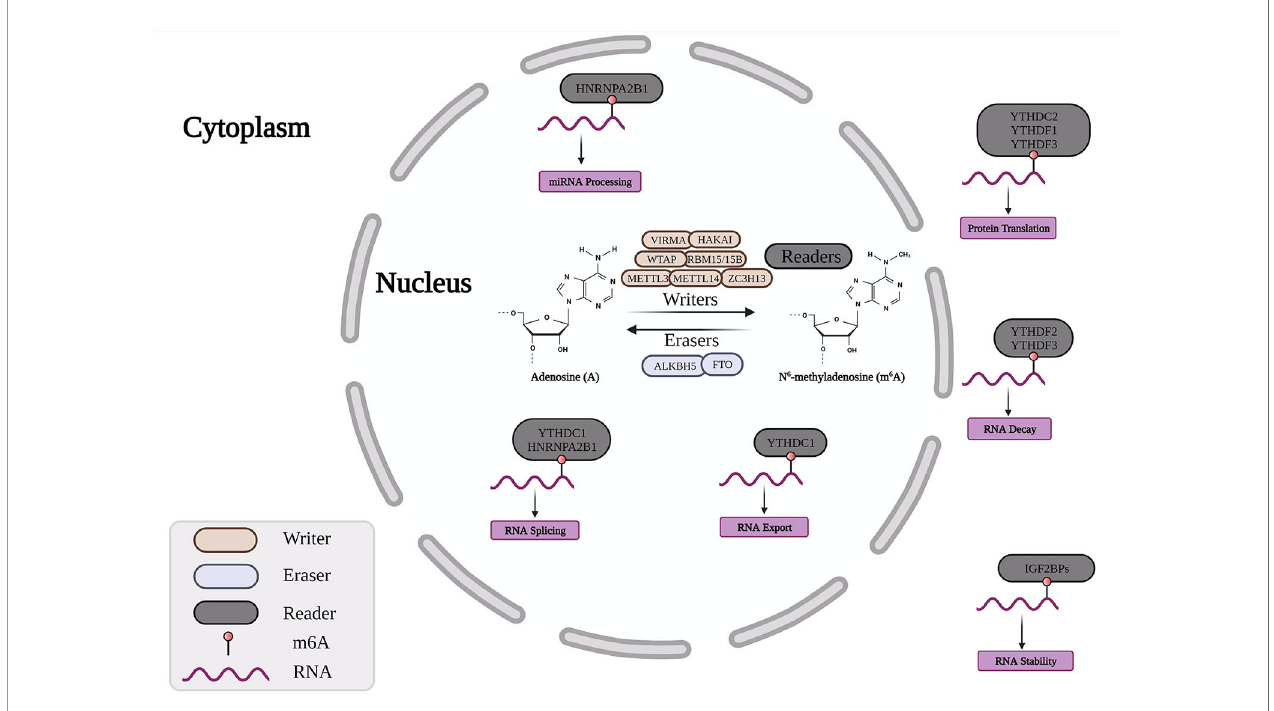
FIGURE 1 | Dynamic m6A RNA modifying process. The RNA modi fi cation of m6A is regulated by methyltransferases ( “ writers ” ), demethylases ( “ erasers ” ) and m6A- binding proteins ( “ readers ” ). VIRMA, Vir Like m6A Methyltransferase Associated; HAKAI, Cbl Proto-Oncogene Like 1; WTAP, Wilms Tumor 1 Associated Protein; RBM15, RNA Binding Motif Protein 15; METTL3, Methyltransferase Like 3; METTL14, Methyltransferase Like 14; ZC3H13, Zinc Finger CCCH-Type Containing 13; ALKBH5, AlkB Homolog 5; FTO, Fat Mass And Obesity-Associated Protein; HNRNP, Heterogeneous Nuclear Ribonucleoprotein; YTHDF, YTH domain protein family; IGF2BP, Insulin Like Growth Factor 2 MRNA Binding